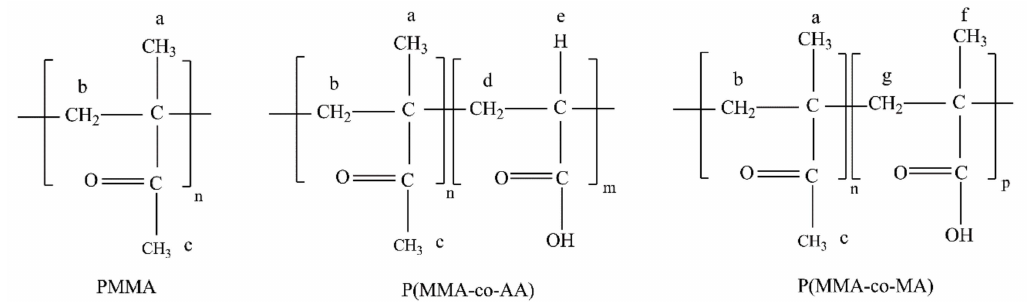
Figure 7. Chemical structure of the (co)polymers and their correspondence to the 1 H NMR spectra.